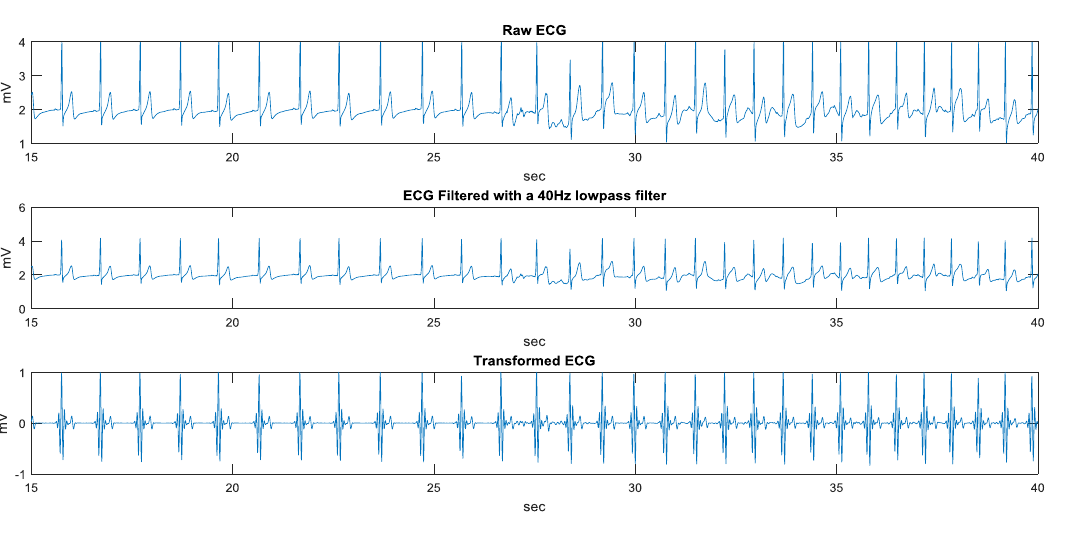
Figure 20. The results of QRS detection, R point recognition, and heart rate curve. 5. Conclusions A real-time QRS detection and R point recognition method for a wearable single lead ECG device was proposed, which consisted of a signal transform, QRS fiducial point detection, and R point recognition. The proposed method is robust and insensitive to baseline wandering, amplitude variation, and atypical QRS waveforms. Verification using the MIT-BIH arrhythmia benchmark demonstrates that the detected sensitivity (Se), positive prediction (+P), and detection error rate (DER) of the proposed method are as good as those reported during existing approaches. The motion artifact issue has been taken into consideration in this study. The testing database, MIT-BIH arrhythmia database, was recorded from an ambulatory ECG device and testing results using the proposed algorithm have been listed in Tables 1 and 3. A study case of ‘walking’ is also demonstrated. In practice, in order to avoid too much computing effort during the de-noise process, we also use a well-designed fixing mechanism to reduce the motion artifact, and the proposed algorithm is thus sufficient to process signals satisfactory for the 120 test clinical study. In conclusion, the proposed method meets the requirement of real-time applications on a mobile phone or an embedded system